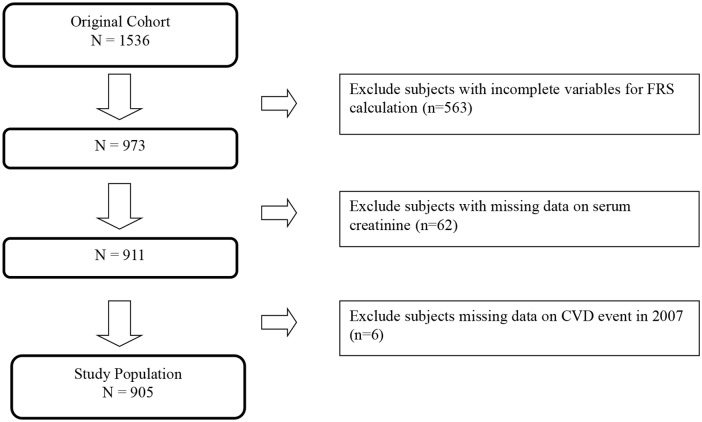
Flowchart of patients included in this study.